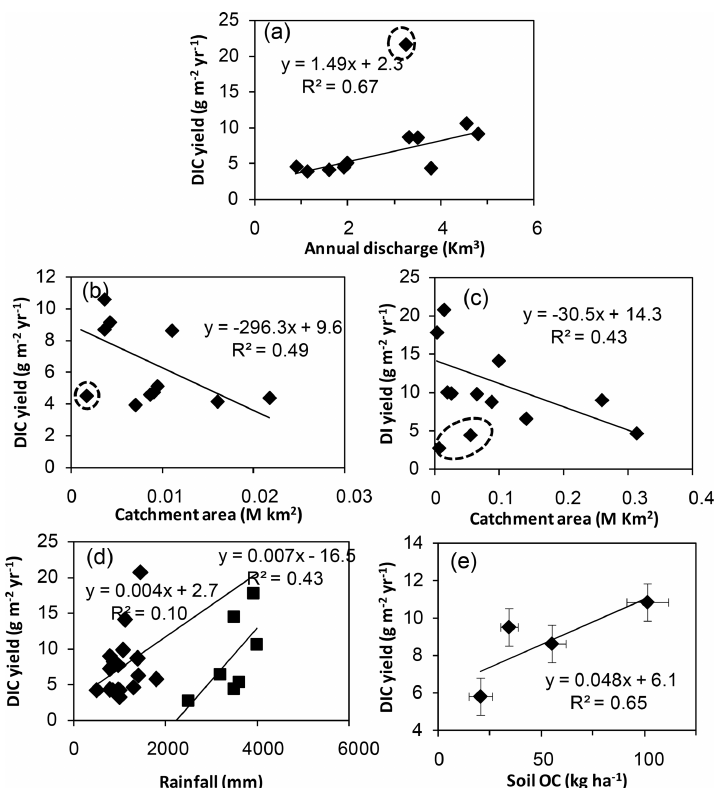
Figure 6. Significant relationships of dissolved inorganic carbon (DIC) yield with (a) river discharge in medium estuaries, (b) catchment areas of the medium-sized rivers, (c) catchment areas of the major rivers, (d) rainfall over the catchment of all the rivers sampled and (e) soil organic carbon (OC) content in catchments of the Indian monsoonal rivers studied. Since the data on soil OC are not available for each watershed, (e) was plotted using the available soil OC data on regional scale (NW, SW, SE and NE regions of India). Hence, it contains only four